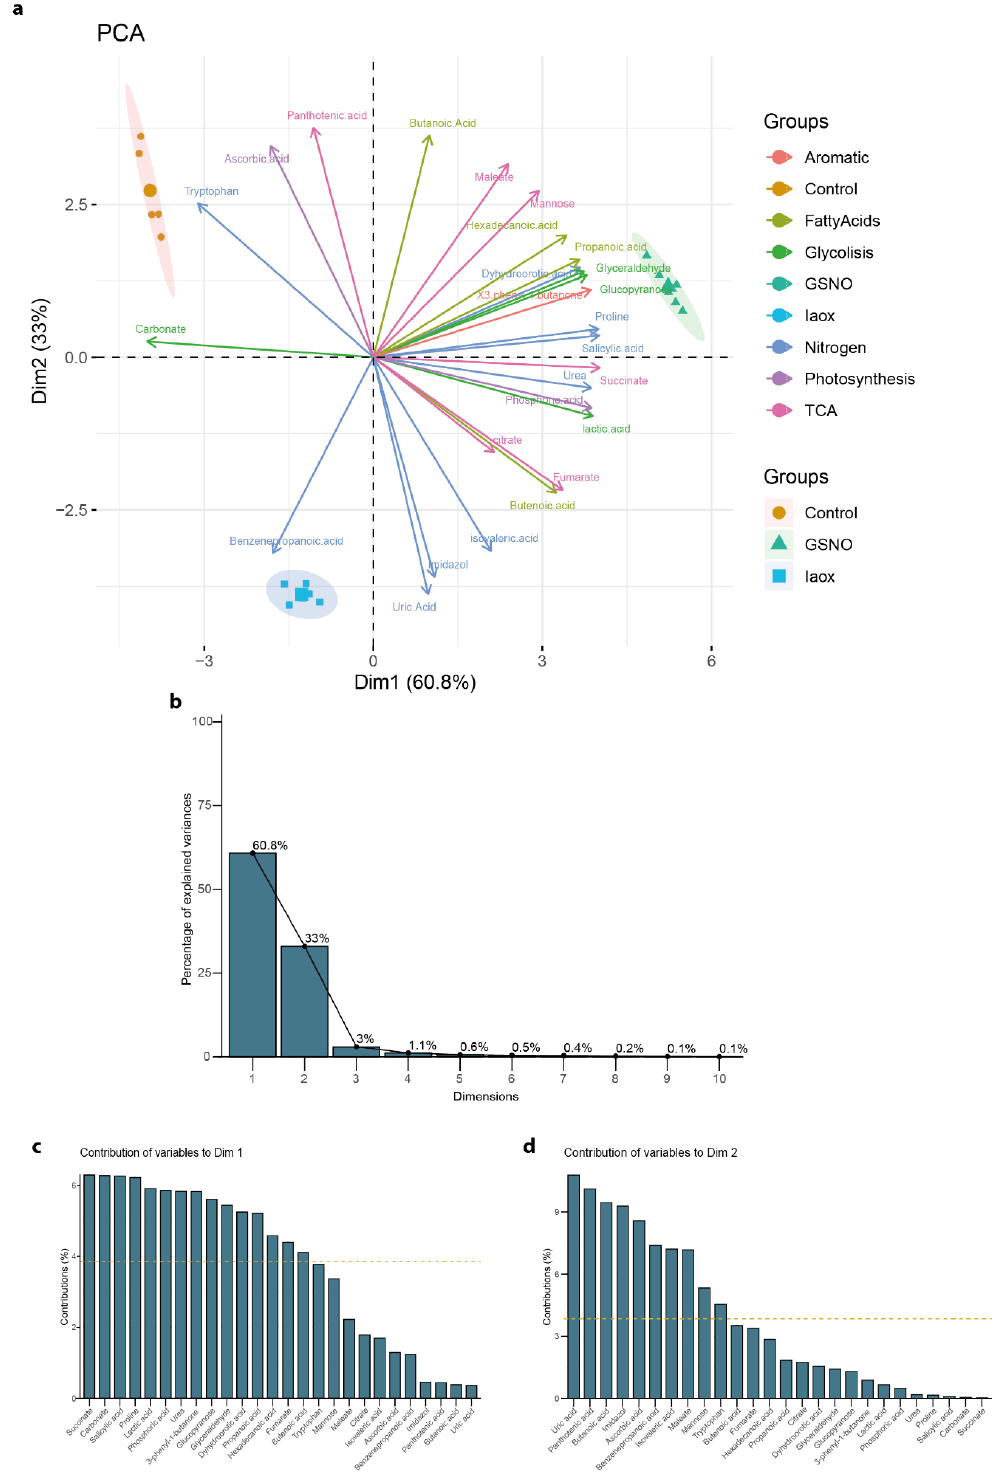
Figure 3. ( a ) The principal component analysis (PCA) of the 26 identified molecules in A. thaliana cells by GC-MS as variables (colored as indicated in legend). The area of each group of samples from the same treatment is depicted as follows: Control (yellow), GSNO (green), and IAOx (blue). The dot size corresponds to loading cos 2 . ( b ) The relative contribution (%) of each dimension to total variation. The relative contribution (%) of each variable to ( c ), Dim1 (PC1), and ( d ) Dim2 (PC2). The average contribution is delimited by a yellow dashed line.